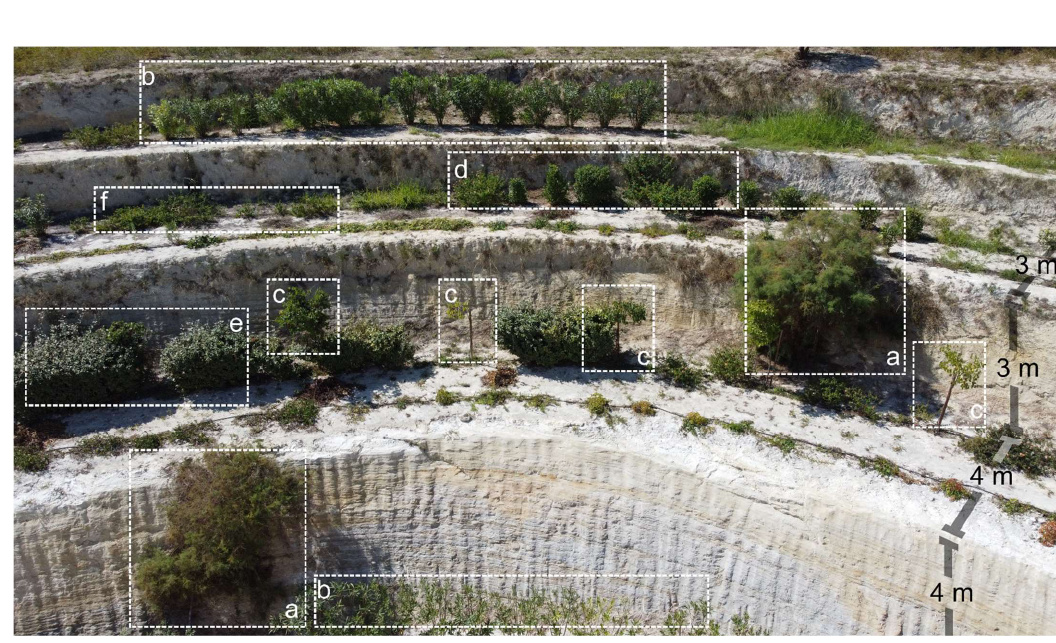
Muscari comosum (L.) Parl.